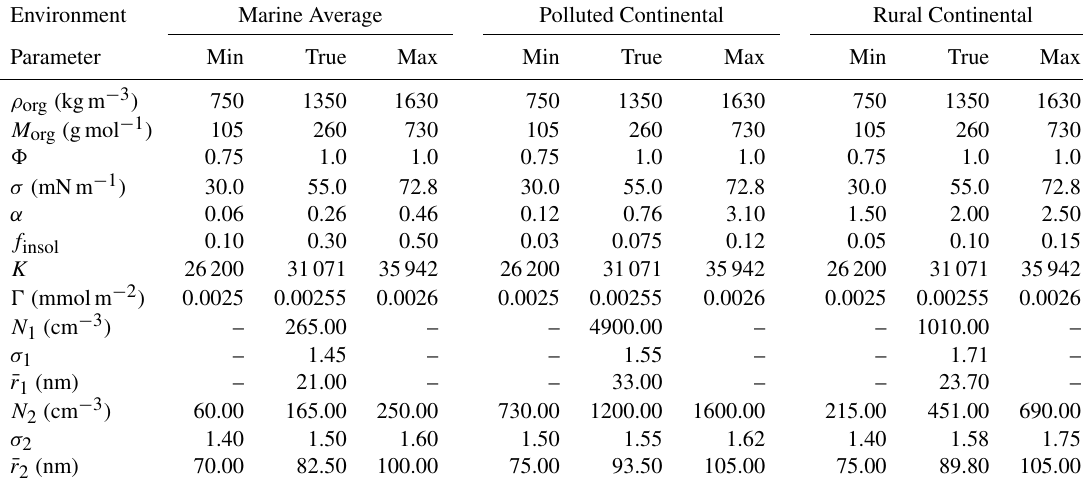
Table 2. True parameter values used for calibration data for all environments and their corresponding parameter ranges used for perturbations in the response surface